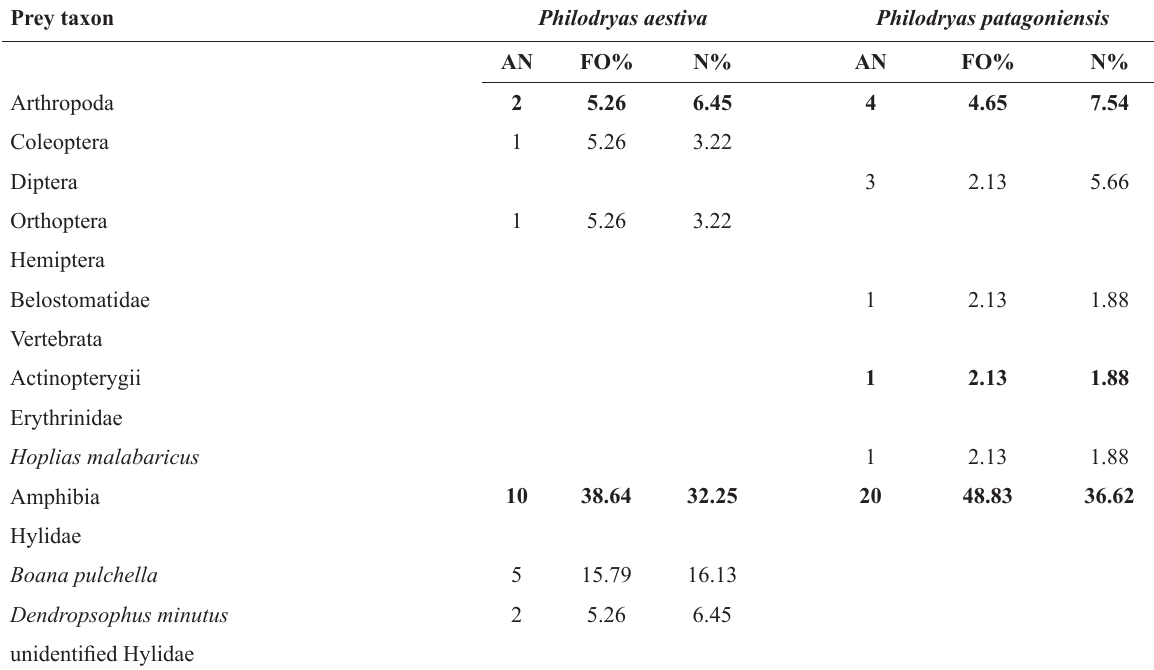
Absolute number (AN), frequency of occurrence (FO%) and numeric abundance index (N%) of each taxon identified in digestive tracts of Philodryas aestiva and Philodryas patagoniensis from the Brazilian coastal Pampa, Rio Grande do Sul